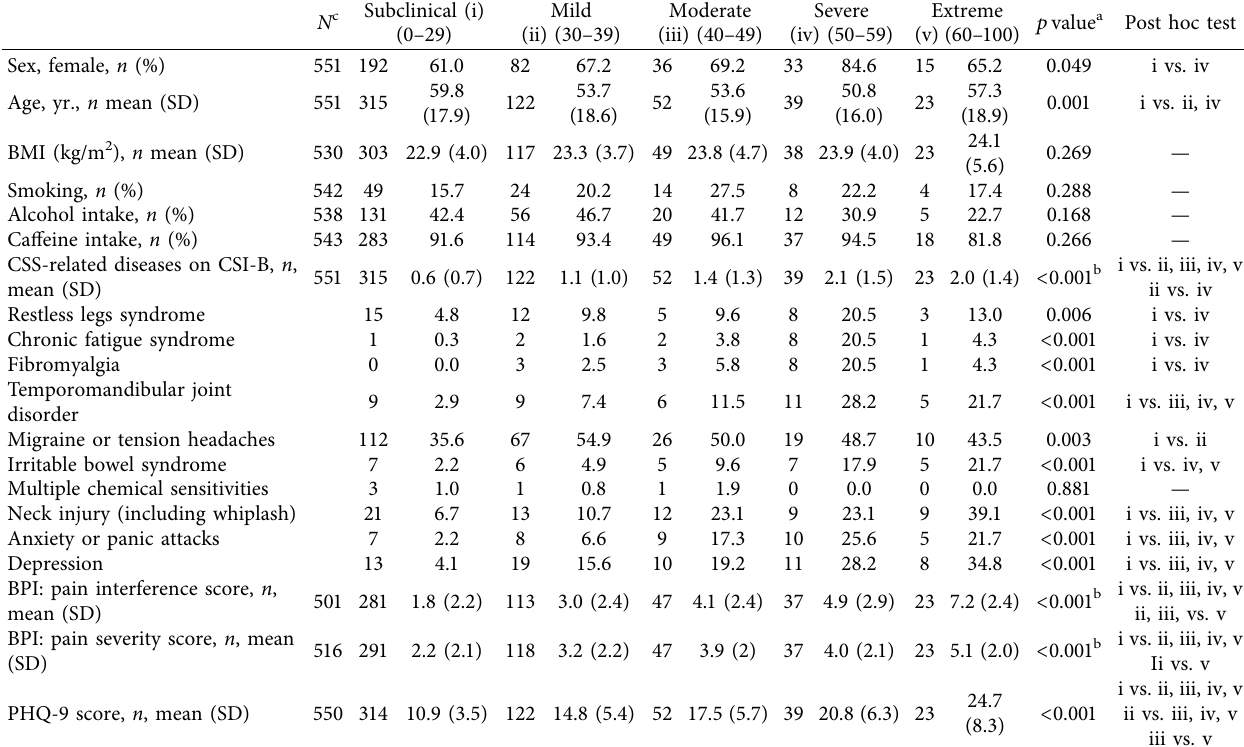
Table 3: Differences in each demographic and clinical parameter among the five CSI-A